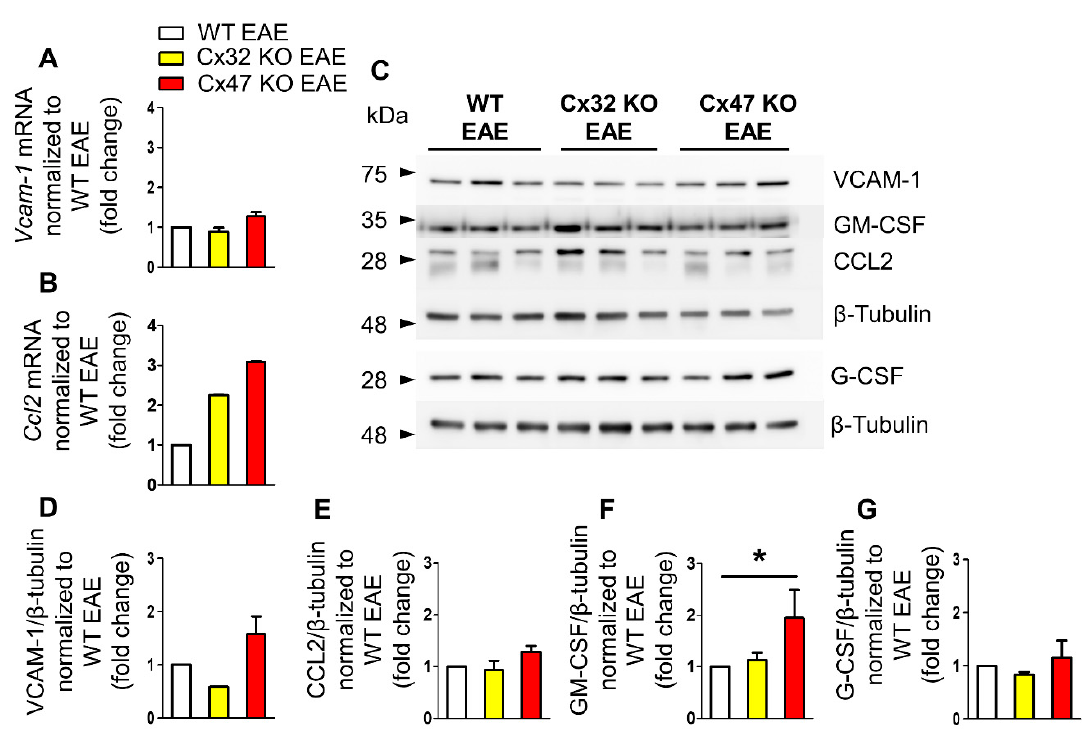
Figure 4. Expression of inflammatory cytokines in the lumbar spinal cord of Cx47 KO and Cx32 KO compared to WT EAE mice at 24 dpi. ( A , B ) Assessment of Vcam-1 ( A ), and Ccl2 ( B ) relative mRNA transcript levels via RT-qPCR in the lumbar spinal cord of n = 4 WT EAE (clinical scores: 2, 2, 3, 2.5), n = 4 Cx32 KO EAE (clinical scores: 2.5, 2, 2, 3), and n = 4 Cx47 KO EAE (clinical scores: 3.5, 4, 3.5, 3.5) at 24 dpi. Gapdh was used as an internal control. Data are presented as mean ± SD. ( C – G ) Representative immunoblot of lumbar spinal cord tissue lysates from n = 3 WT EAE (clinical scores: 3.5, 3, 1.5), Cx32 KO EAE (clinical scores: 4, 4.5, 2.5), and Cx47 KO EAE mice (clinical scores: 4, 3.5, 4) at 24 dpi and quantification of relative protein levels of VCAM-1 ( D ), CCL2 ( E ), GM-CSF ( F ), and G-CSF ( G ) determined by densitometric analysis using ImageJ. β -Tubulin was used as loading control. Data are presented as mean ± SD. One-way ANOVA with post hoc Tukey’s HSD test: * p < 0.05.